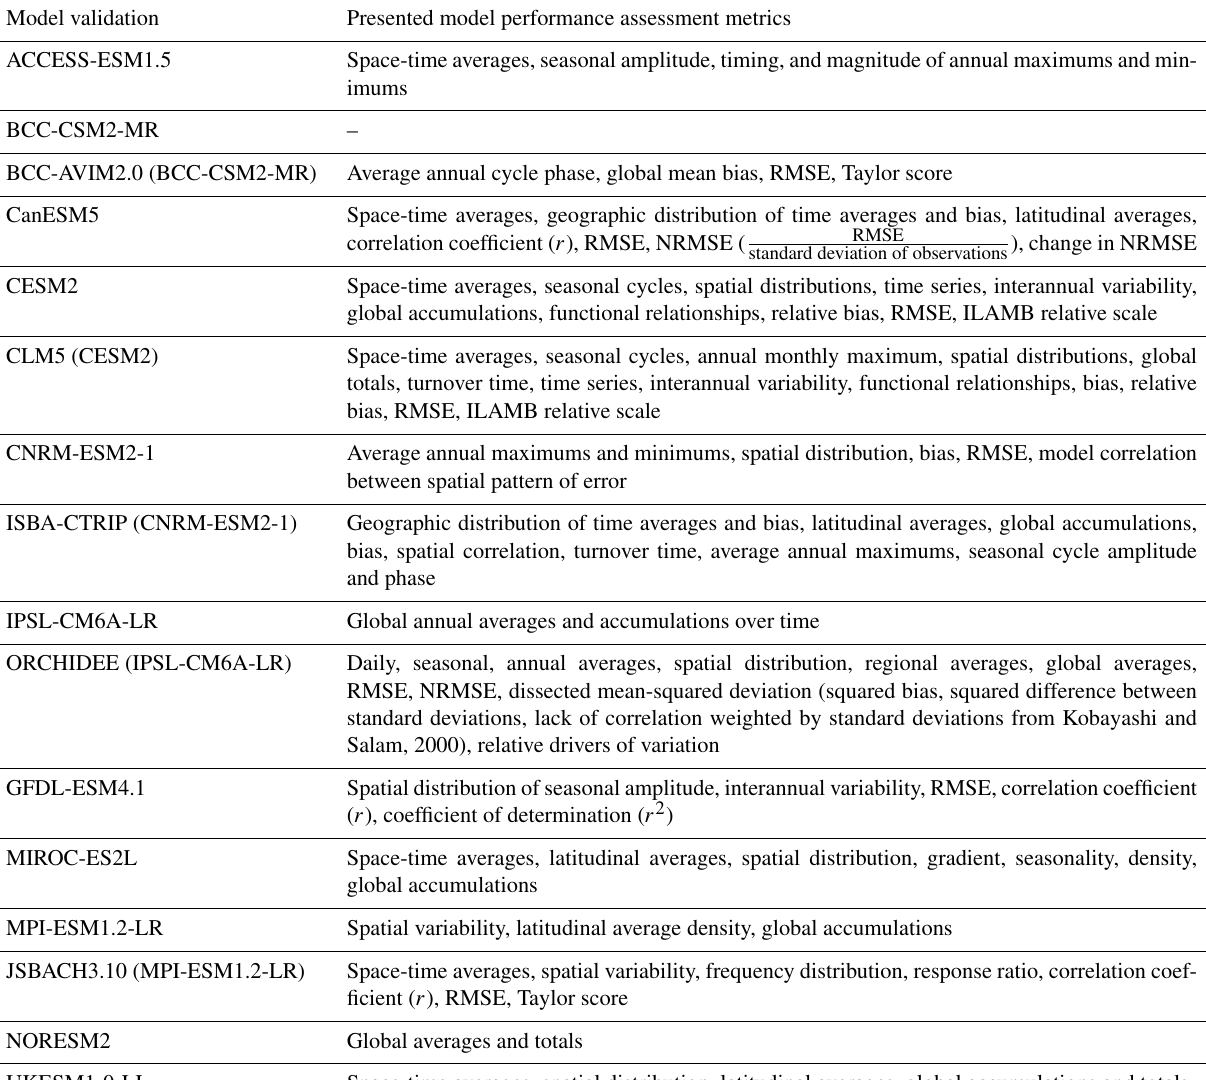
Table 5. Model performance metrics used by each modelling group for ESM or LSM simulations. Adjacent contributions from the same modelling group are banded in a common fashion for readability. LSM-focused validations by each modelling group are presented with the associated ESM in